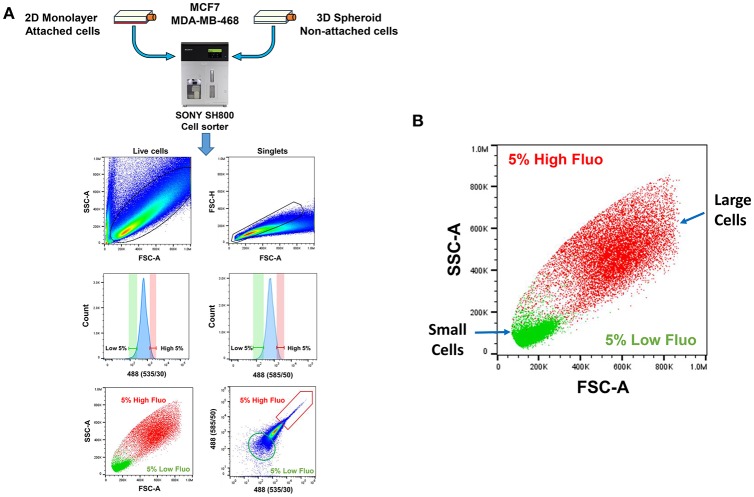
Technical scheme for isolating e-CSCs, via flow-cytometry. (A) See “Experimental Procedures” for a more detailed explanation. Briefly, single-cell suspensions were prepared from 2D-monolayers or 3D-spheroid cell cultures. Then, these single-cell suspensions were subjected to flow-cytometry, using the SONY SH800 cell sorter. This allowed us to select the flavin-specific auto-fluorescent (AF) cell population by gating. First, only live cells were selected; then, only singlet cells were selected, by using the forward- and side-scatter parameters. Ultimately, the “AF-high” (top 5%) and the “AF-low” (bottom 5%) sub-populations were selected, by plotting the signal from the 488(535/30) nm laser vs. the 488 (585/50) nm laser. (B) Plotting forward scatter vs. side scatter gives an estimate of relative cell size. Note that AF-high cells are considerably larger than AF-low cells. This may also reflect their increased metabolic activity.